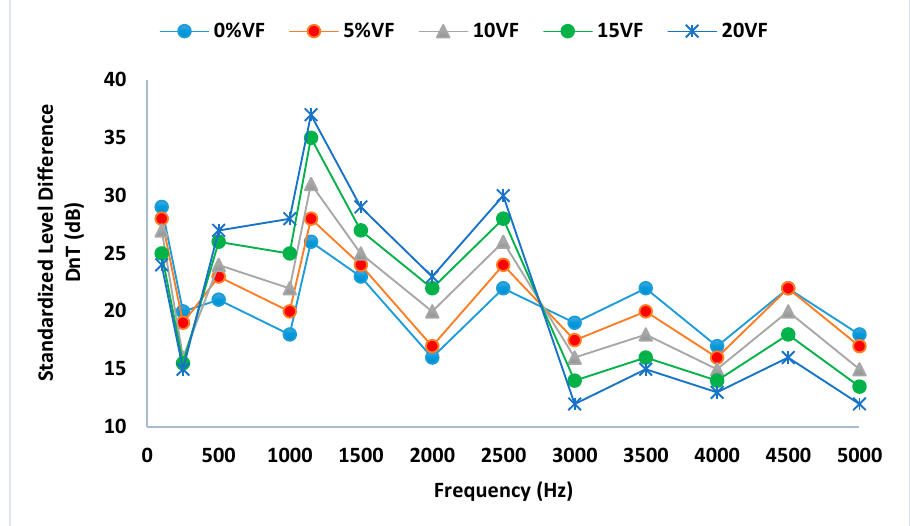
Figure 11. Effect of PO fibers on the standardized level difference of the mixtures.